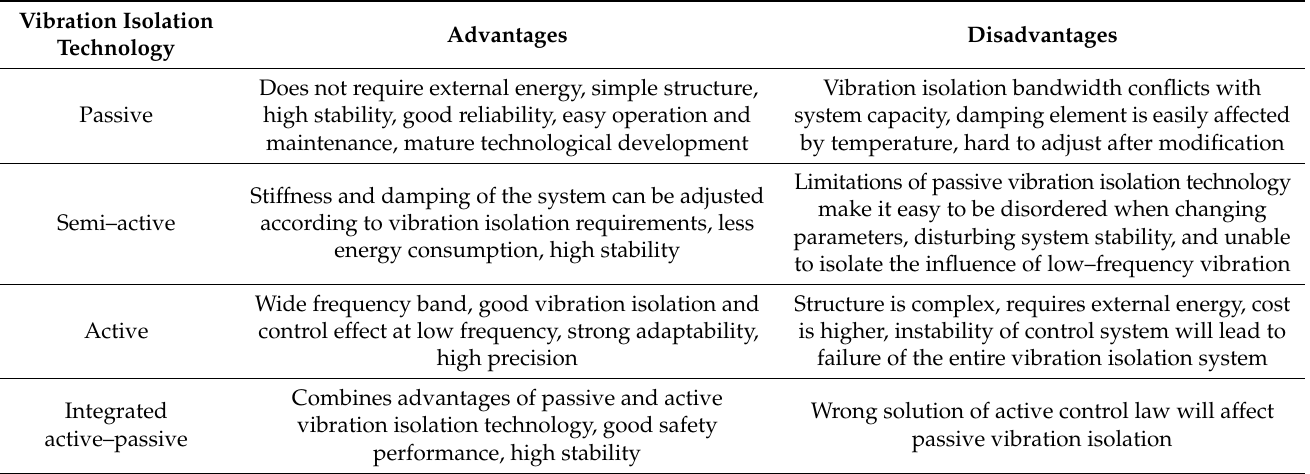
Table 1. Comparison of characteristics of four vibration isolation technologies.